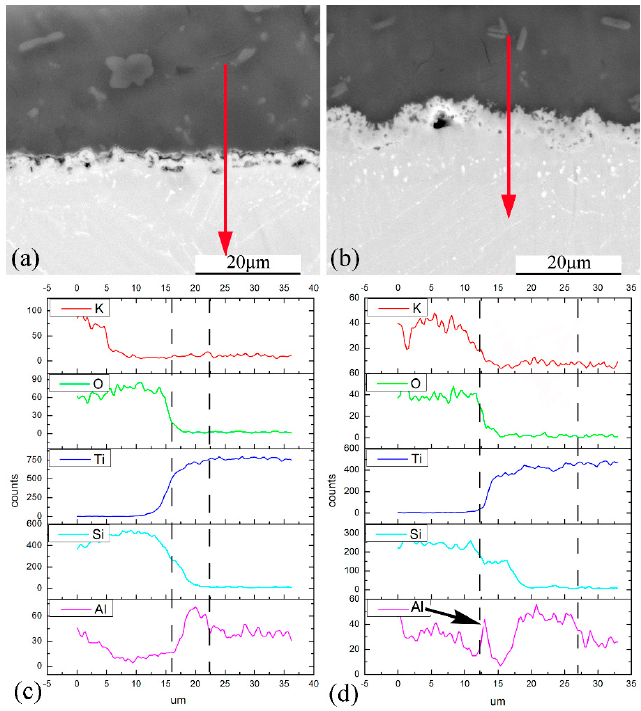
Figure 7. Elemental distribution of coating/alloy interface after oxidation at 800 °C ( a , c ) and 900 °C ( b , d ) for 100 h by EDS line-scan.